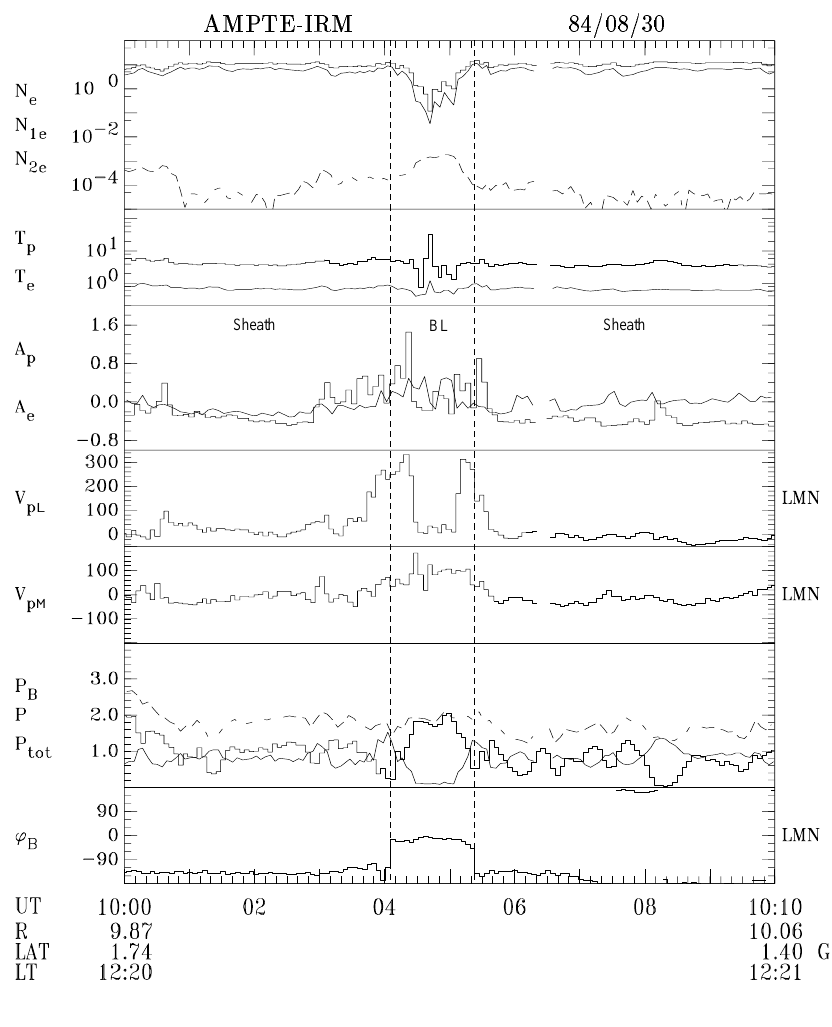
Fig. 4. Overview of the magnetopause pass on 30 August 1984. The format is the same as in Fig.